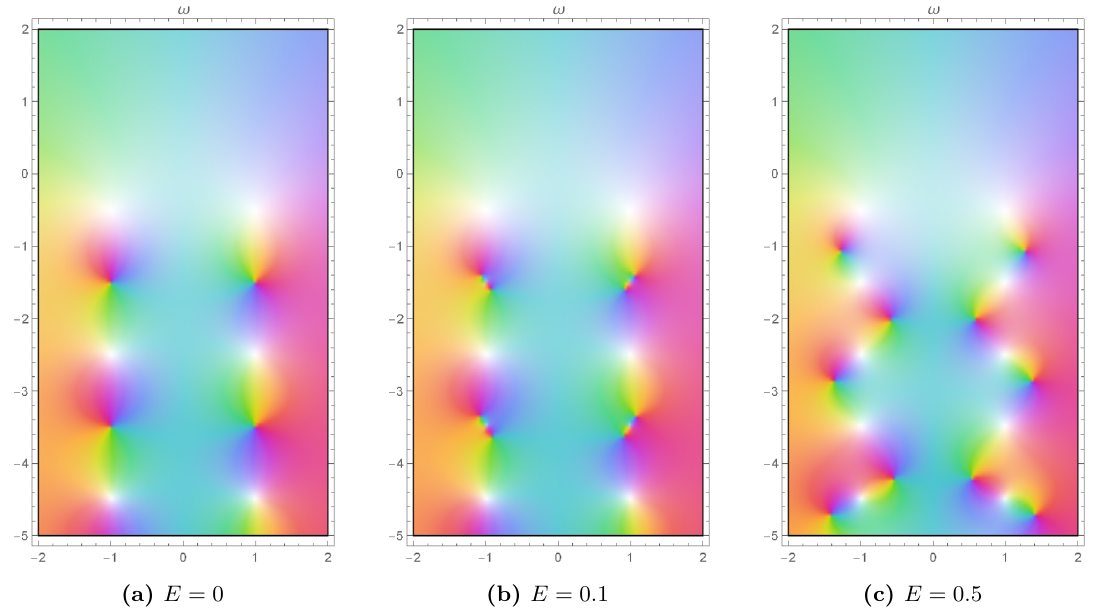
Figure 6. A phase plot of the retarded static patch propagator G R at coincidence, see (3.30), as a function of the frequency ω , evaluated at ∆ = 1 + i , for different values of the electric field E . All 2 poles are located on the lower half of the complex plane. The 2 towers of quasinormal modes (3.24) are clearly visible. For E = 0 , one alternatingly has poles and zeros at these frequencies. When switching on the field, the zeros split up, and all quasinormal frequencies appear as poles of G . R